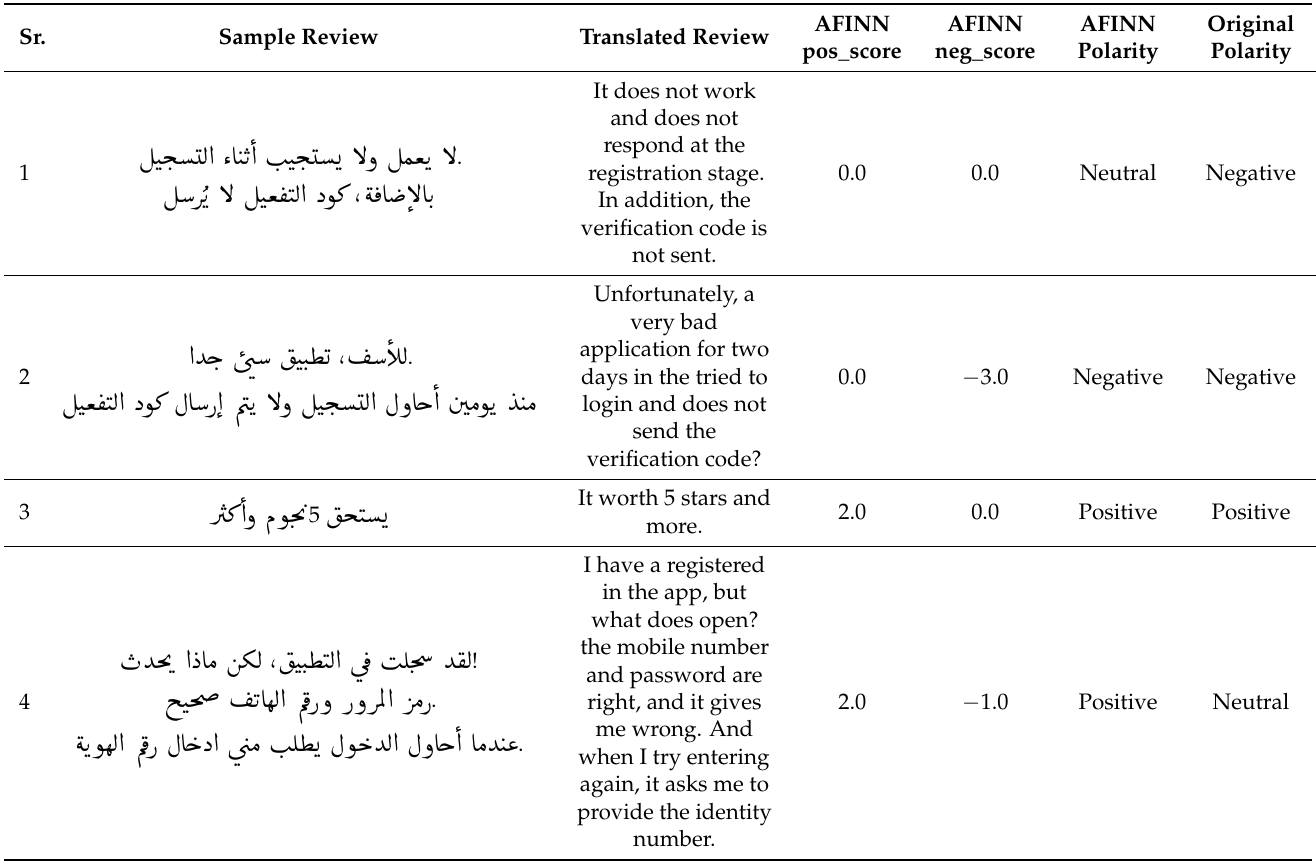
Table 7. A sample of reviews with AFINN lexicon scores and their polarity. Sr.